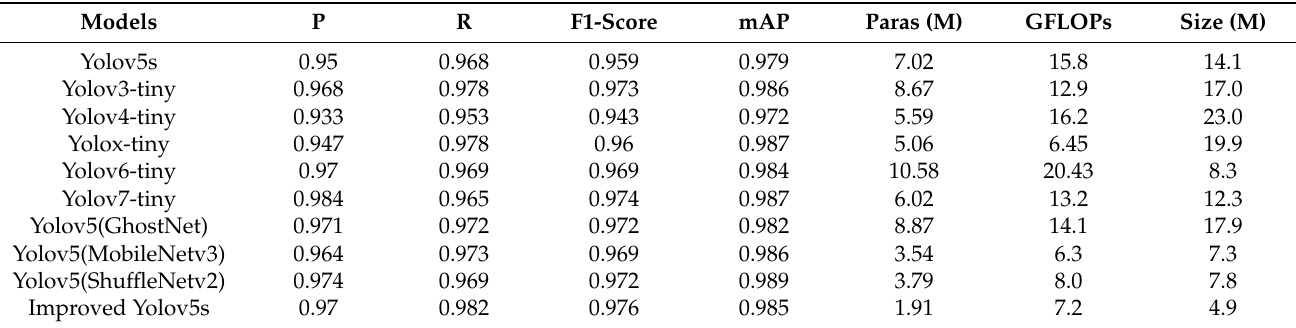
Table 7. Performance of different